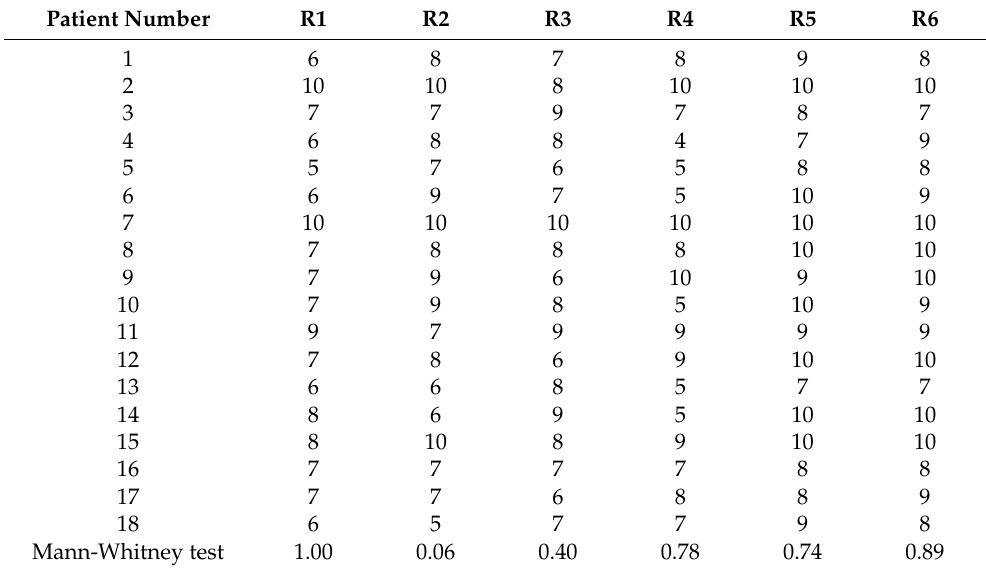
Table 5. Rustemeyer’s questionnaire results.